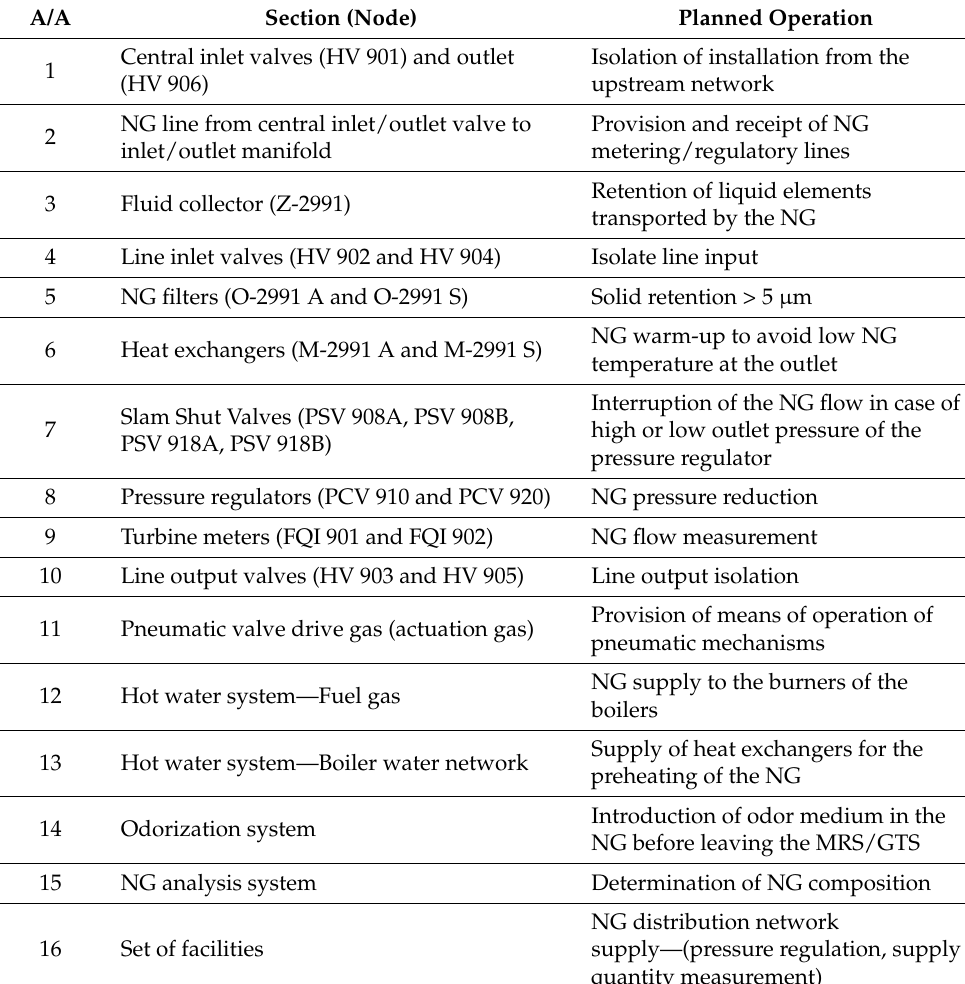
Table 4. HAZOP study elements and guidewords for the